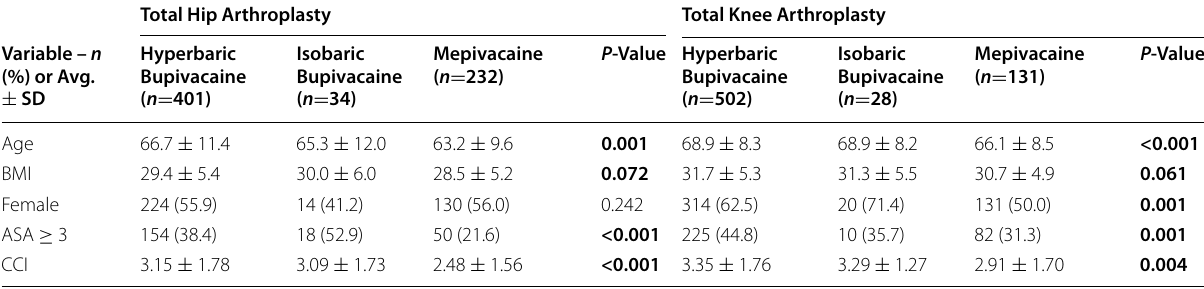
P -Values <0.05 in bold BMI body mass index, ASA American Society of Anesthesiologists Score, CCI Charlson Comorbidity Index